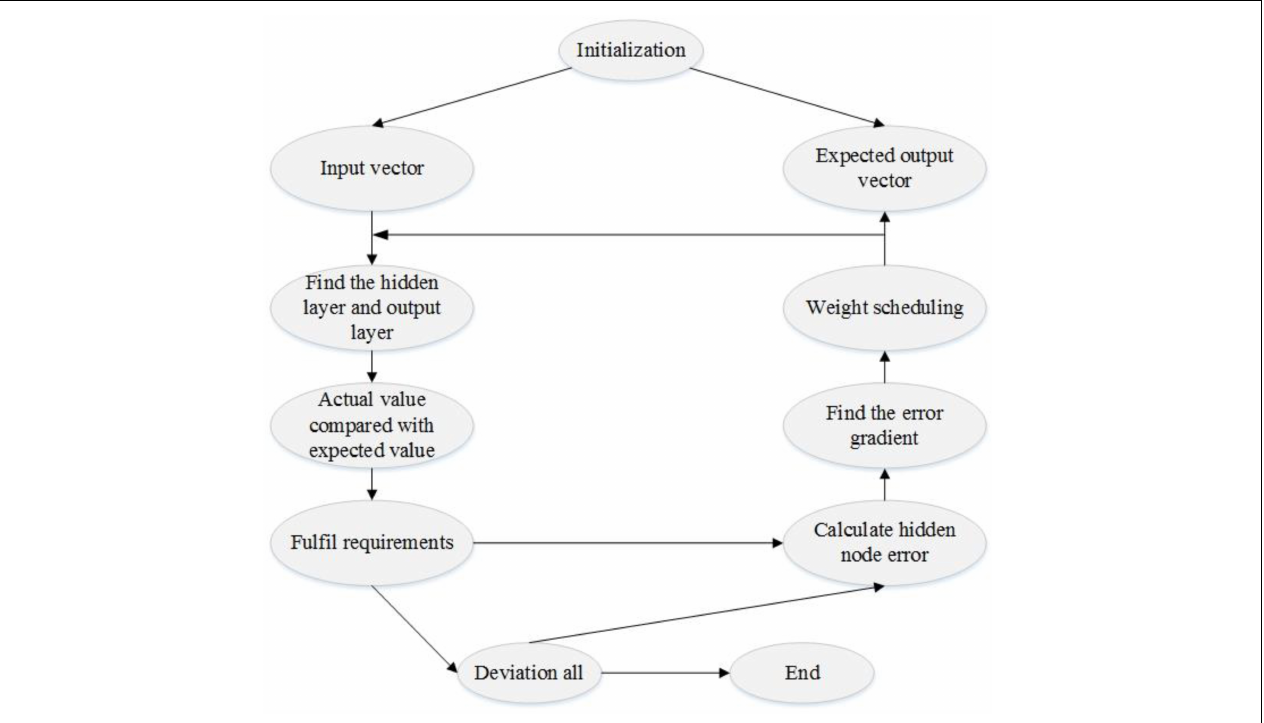
FIGURE 2 | BP artificial neural network risk assessment